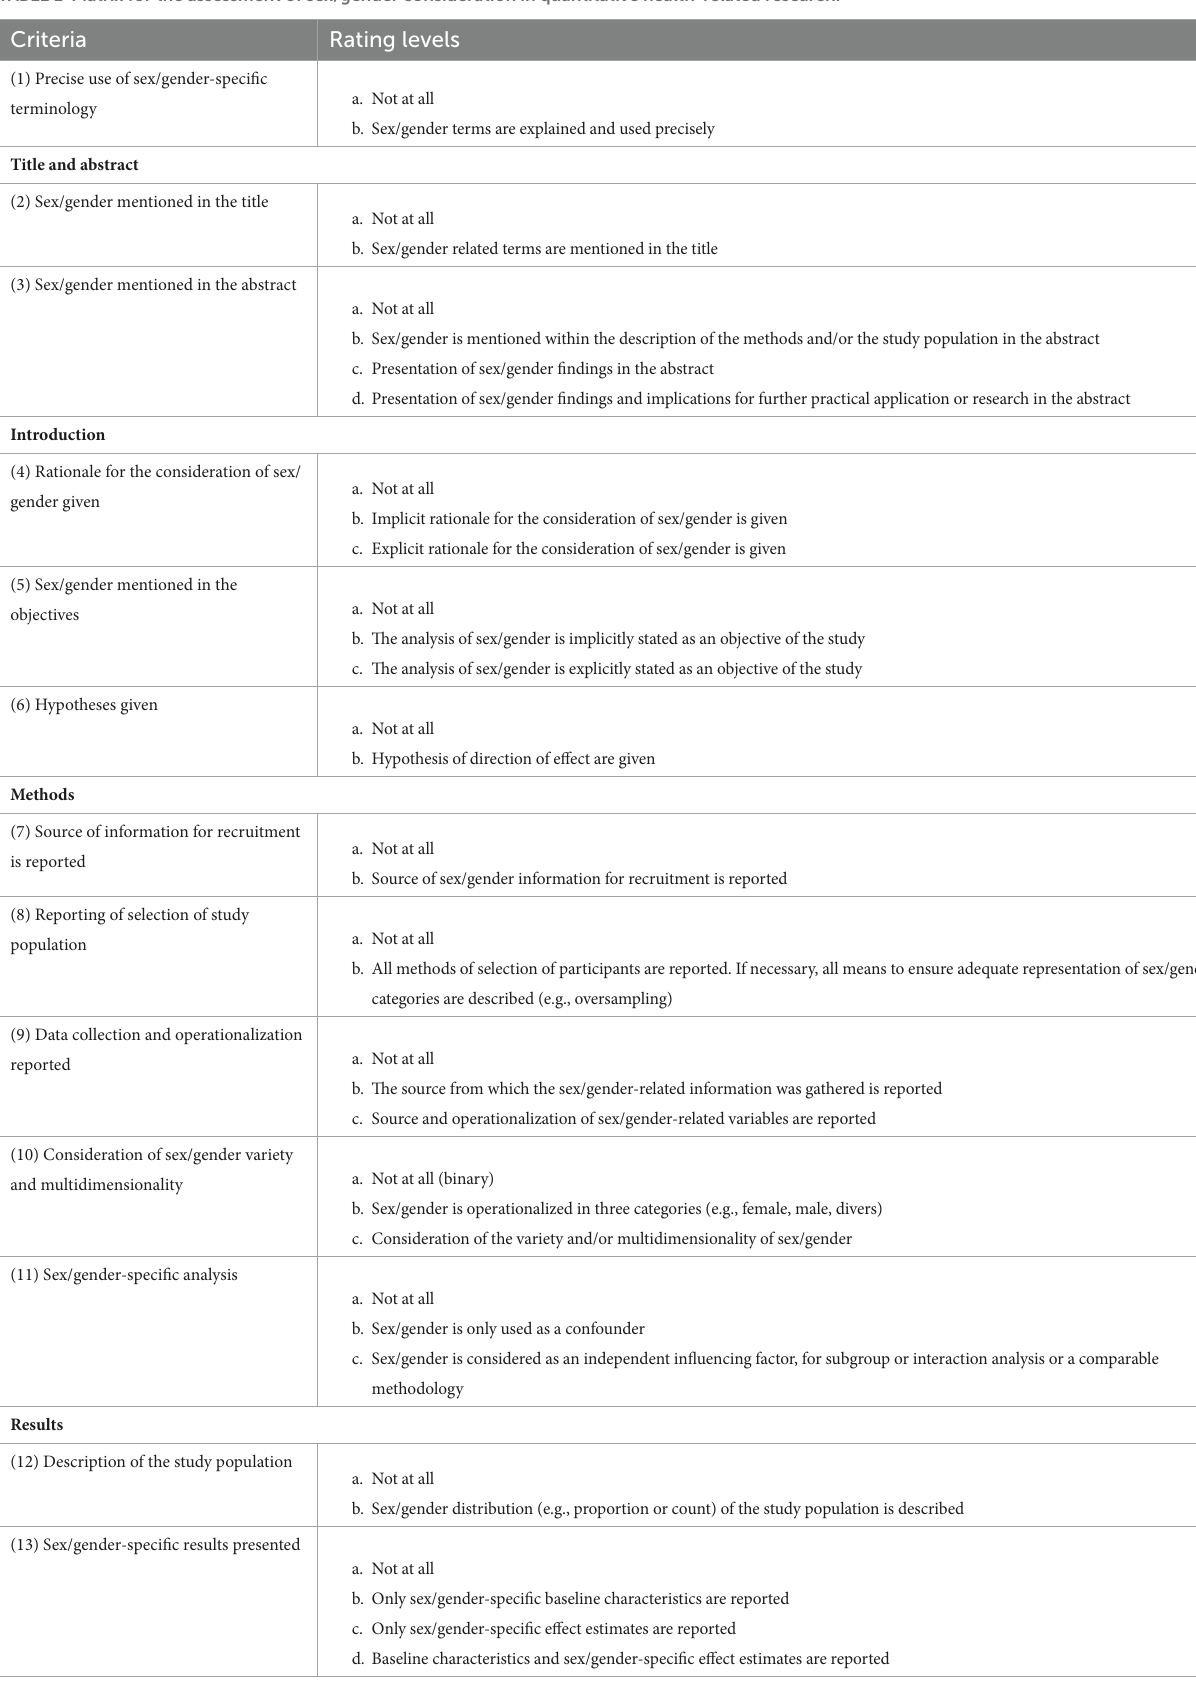
TABLE 1 Matrix for the assessment of sex/gender consideration in quantitative health-related research. Criteria Rating